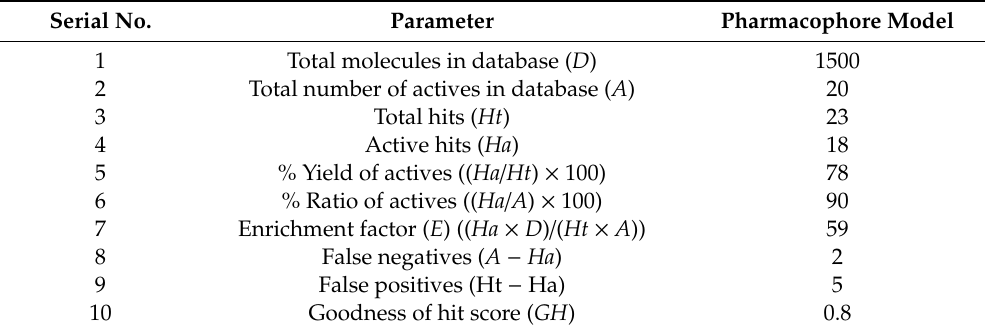
Table 2. Pharmacophore model validation using GH score method.